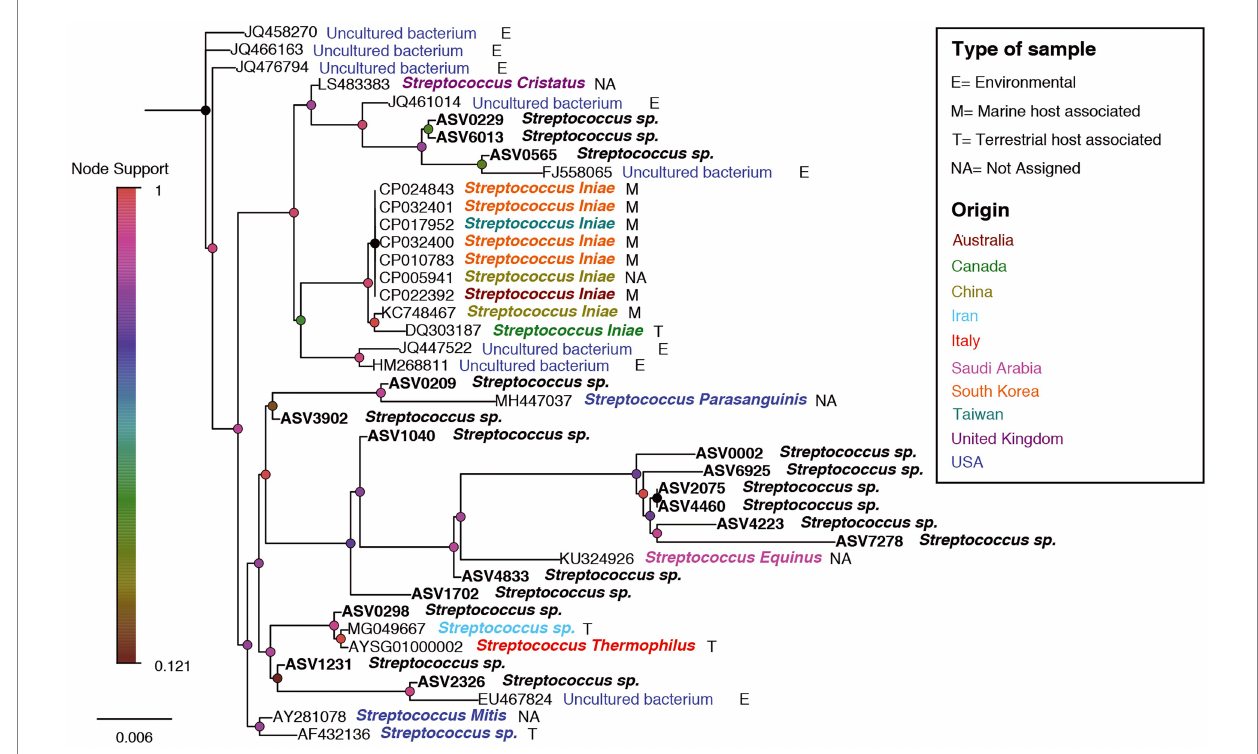
FIGURE 8 A phylogenetic tree for Streptococcus -related ASVs and accessions no. from NCBI. ASV0002 is marked by a red arrow. Nodes are colored according to the node-support bar. The taxonomy, next to ASV/Accession No., is colored according to the geographic origin while the letters (E/M/T/NA) represent the type of sample, according to the attached legend.